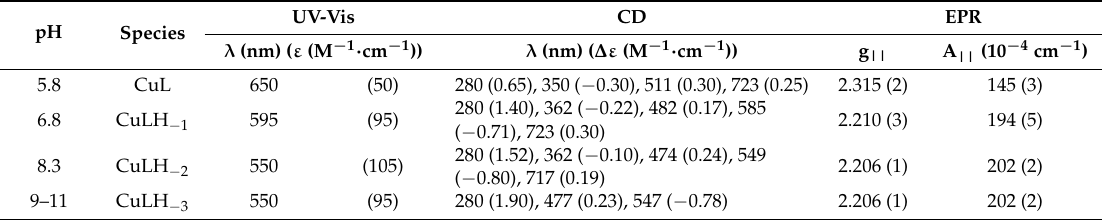
Spectroscopic parameters of copper(II) complexes with Ac-SLHHLG-NH 2